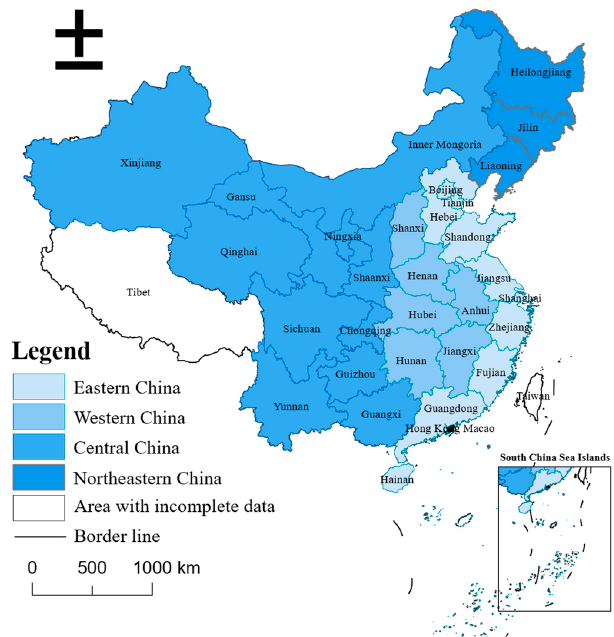
Figure 1. Visual distribution map of four regions in China.